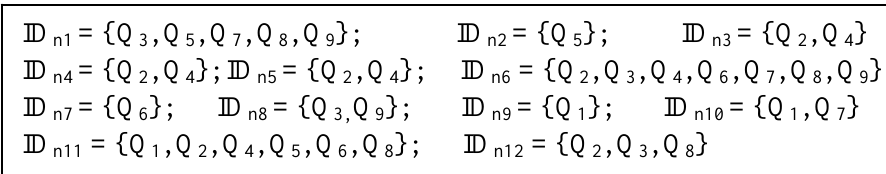
Fig. 4: ID of each node in the GQG in Fig. n